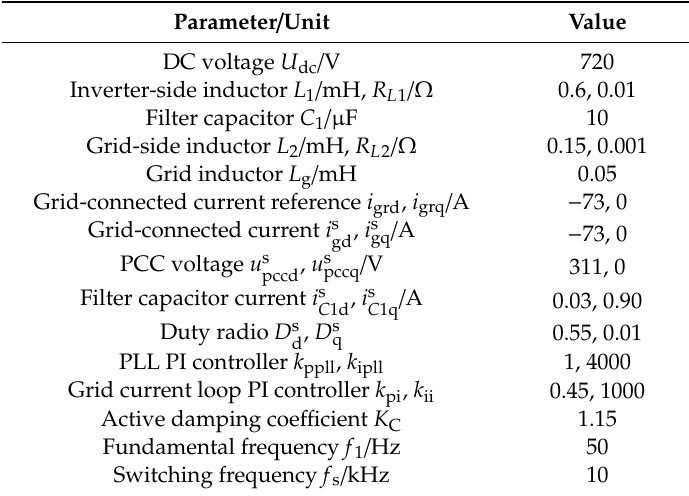
Figure 14. Experimental platform for a three-phase grid-connected system. ( a ) Whole; ( b ) Details. Table 1. System